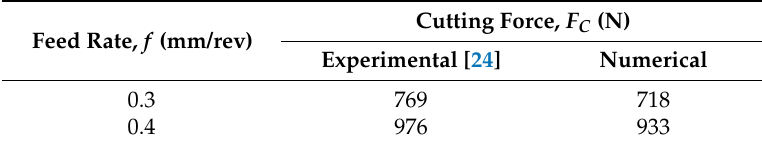
Table 3. Cutting forces for V C = 800 m/min, γ = 17.5 ◦ , a P = 4 mm.